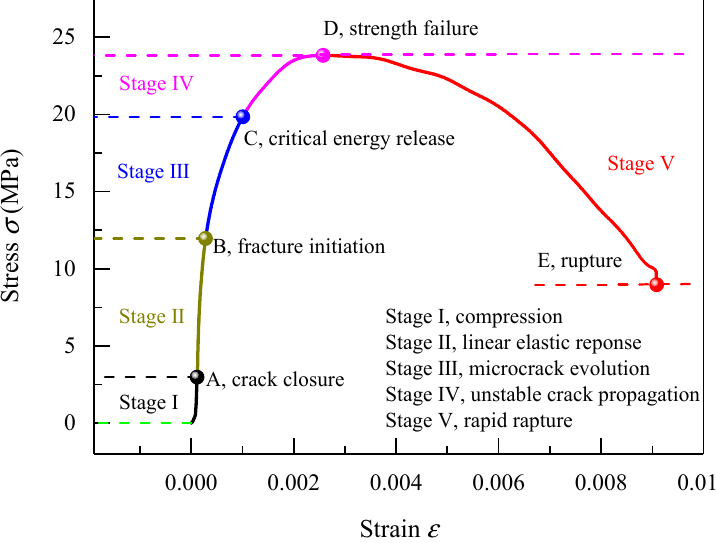
Figure 5. Characteristic composite stress-strain constitutive curve of coal specimen in SHPB test— assembled based on dominant processes acting at different stages of loading and